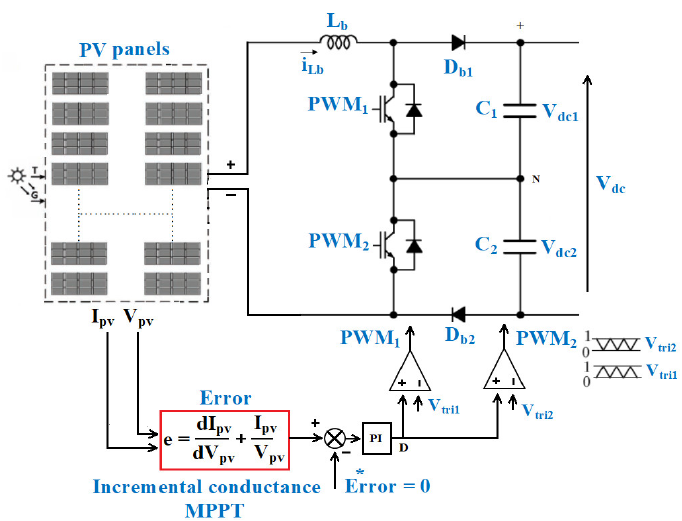
Figure 3. MPPT control of the PV based on three-level boost converter, where “*” indicate reference of Error.